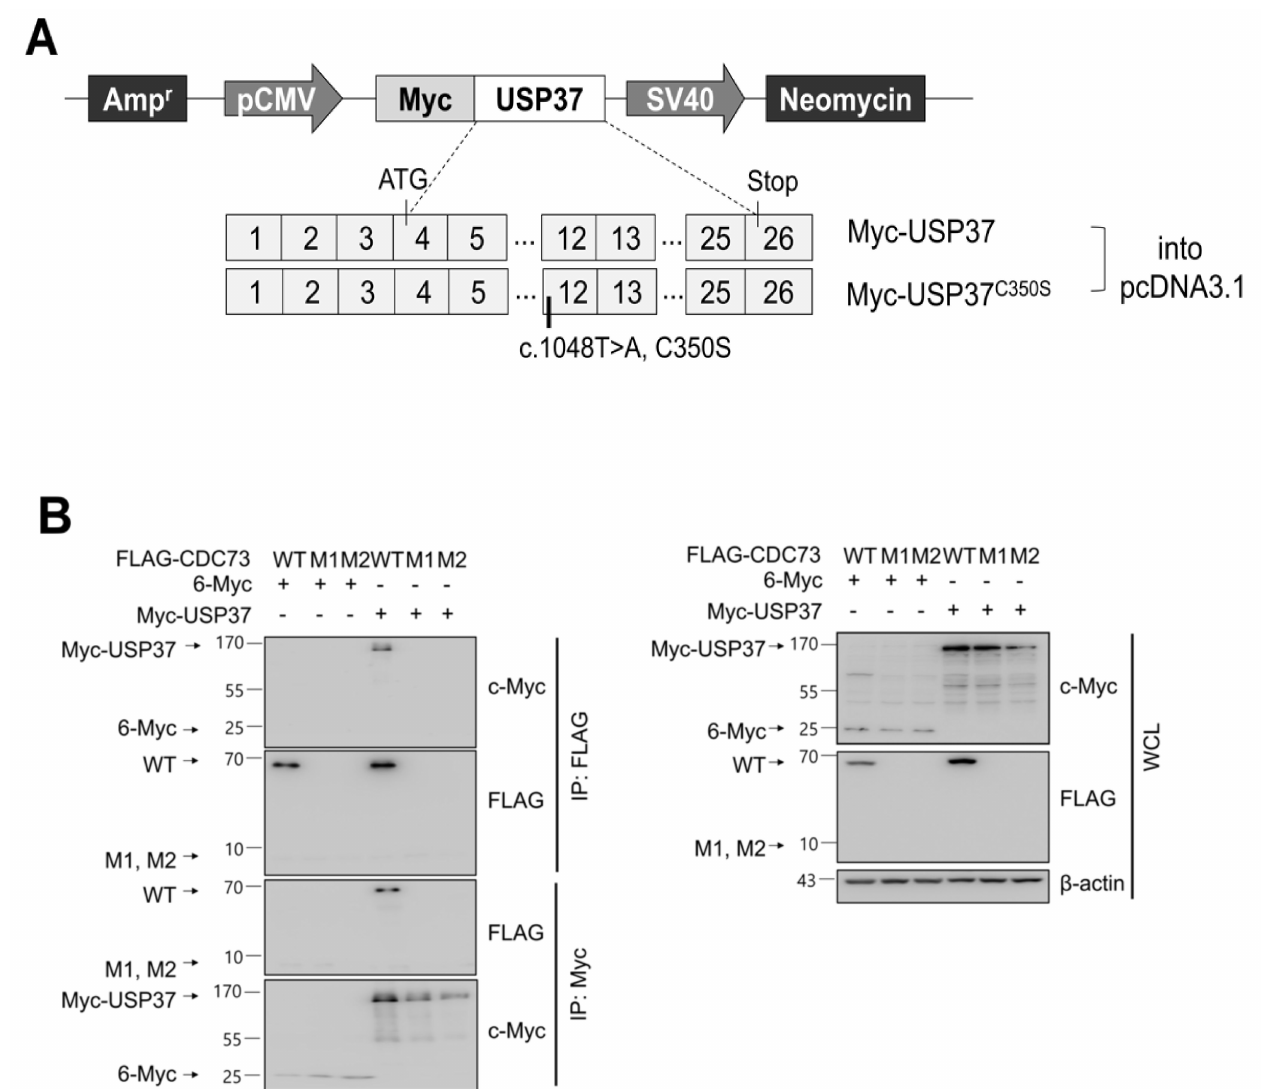
Figure 3. CDC73 interacts with USP37. Schematic diagram of USP37 and inactive USP37 C350S expression vectors ( A ). For CDC73 deubiquitination by USP37, full-length USP37 (or USP37 C350S ) was cloned into pcDNA3.1 vector with an N-terminal c-Myc tag. Reciprocal binding between CDC73 and USP37 results from co-IP experiments performed in COS7 cells ( B ). COS7 cells were transfected with FLAG-CDC73/pcDNA3.1 or Myc-USP37/pcDNA3.1 expression vectors. The interaction